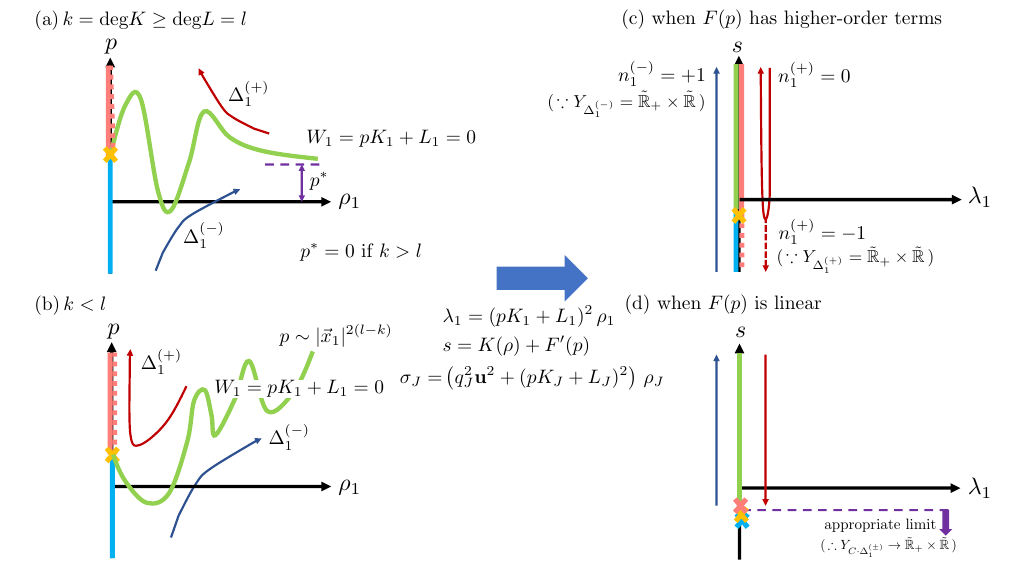
Figure 2 . The domain decomposition and mapping under reparameterization (4.23) for (cid:10) I =1 of W = P K ( (cid:26) ) + L ( (cid:26) ) + F ( P ) theory. The angular part and other directions such as (cid:26) I (cid:1) ignored to avoid the